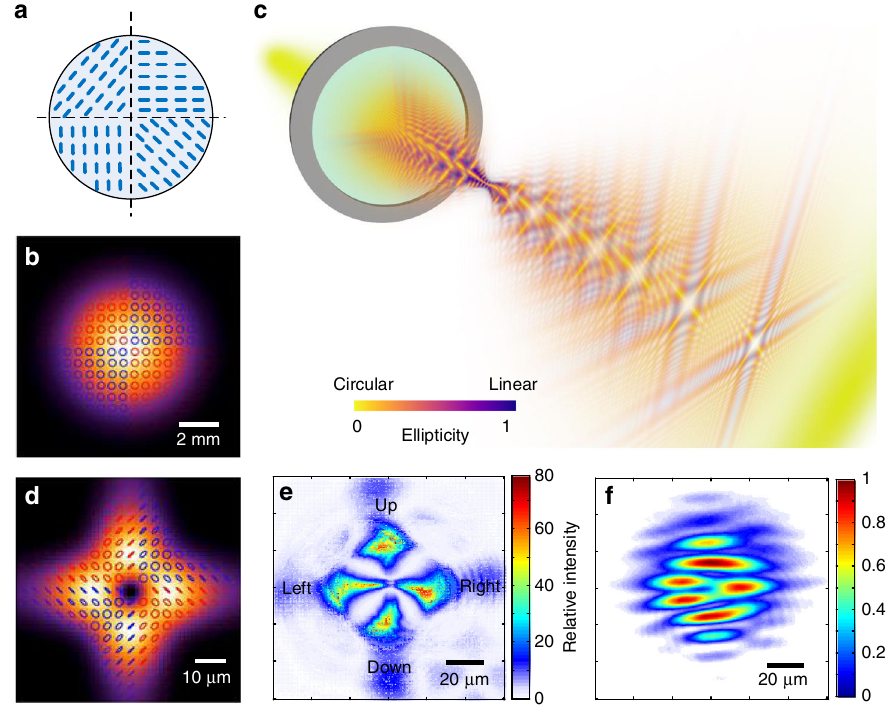
Fig. 1 Shaping and characterizing the optical polarization of the fundamental driving laser beam. a Design of the liquid crystal phase plate. The short blue lines represent the orientation of the aligned liquid crystal molecules. b Intensity and polarization plot of the fundamental beam in the near fi eld; the blue and red parts distinguish four segments delayed by π /2-phase. c The evolution of polarization state of a vector beam while it is being focused. The yellow- colored part shows where the polarization is circular and blue-colored part shows where it is linear. The linear parts start to show up at the interface between adjacent segments and are dominant at the focal plane. The circular state is restored when the beam propagates away from the focal plane. d Intensity and polarization plot of the driving infrared beam at the focal plane. Linear polarization states are constructed within the four intense lobes, where high harmonics are produced. e Measured ratios between the maximum and minimum intensity at each point in space for various rotation angles of the linear polarizer. A higher distinguish ratio indicates that the local polarization state is more linear. f The interference pattern between the fundamental vector beam and Gaussian beam at the focal plane. The shifted fringe pattern indicates a π -phase difference between the opposing segments, and each segment is phase delayed from this neighbor by π /2